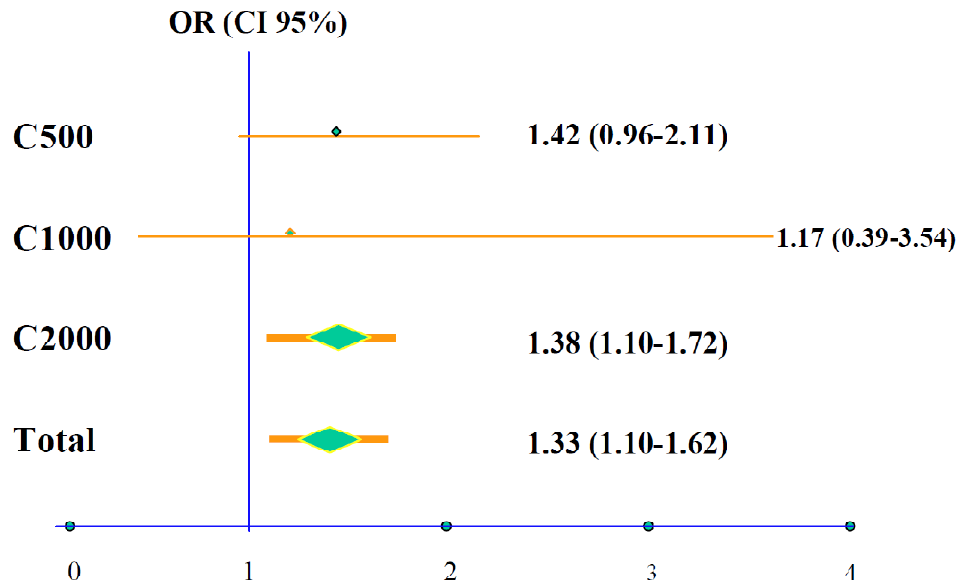
Figure 2. Probability of total recovery according to daily dose of citicoline among patients included in the pooled data analysis ( N = 789 subjects on citicoline compared with 583 on